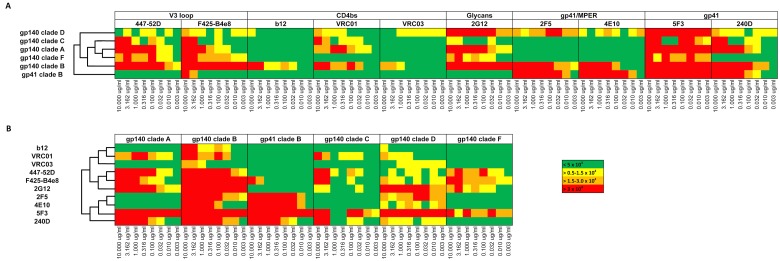
Cluster analysis. Arrays were probed with mAbs diluted in a series of 8 half log concentrations as described in the text.The heat map displays intensity with orange (>1.5–3.0 x 104) and red (>3.0 x 104) showing the strongest, green (<5.0 x 103) the weakest, and yellow (>0.5–1.5 x 104) intermediate according to Fig 1. MeV v4.6 (TM4Microarray Software Suite, www.tm4.org) was used to perform the hierarchical clustering analysis using average linkage clustering. Samples are clustered according to response against protein antigen spots (1.0 ng per spot) on the array.